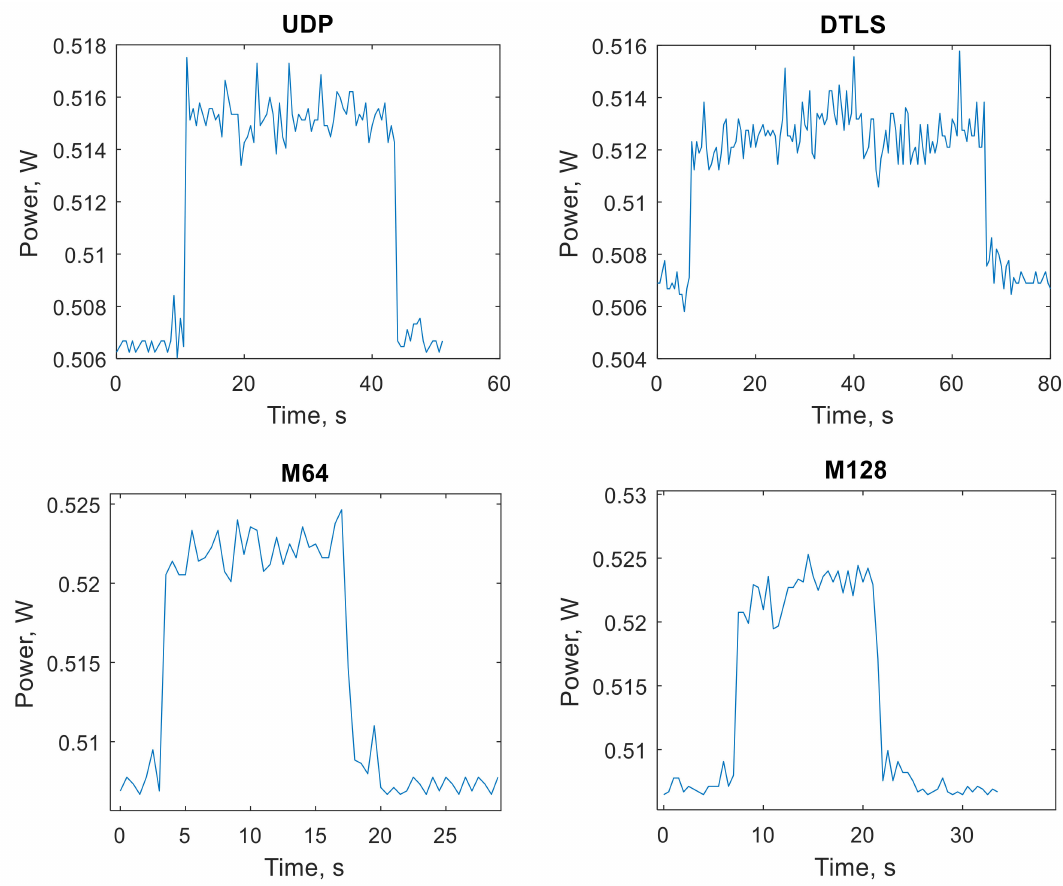
Figure 5. Power consumption of the Wi-Fi network card while transferring 1 MB of data using 2048 B data packets and di ff erent transport